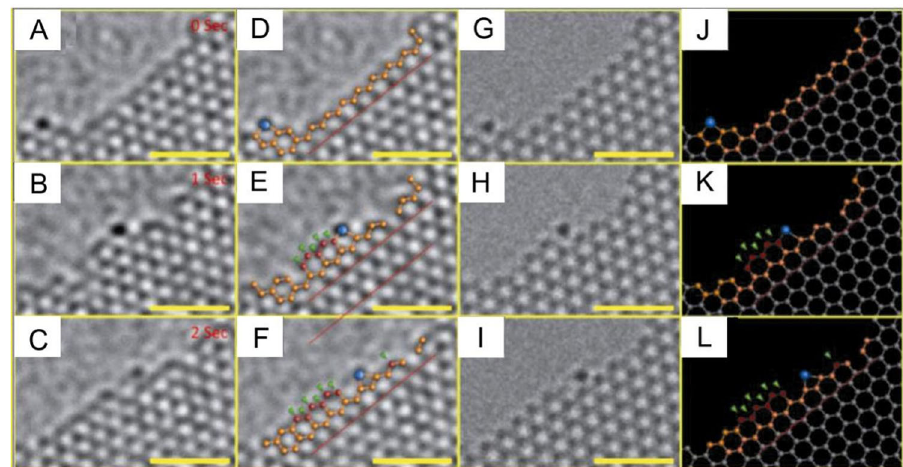
Fig. 5 Catalytic growth of graphene by a single Cr atom at the graphene edge under electron beam irradiation. A – C , with partial stick- and-ball models to aid viewing ( D ) – ( F ), image simulations of the growth process G – I , and complete stick-and-ball models J – L . The blue ball indicates Cr, whereas red balls and green arrows signify new C atoms. All scale bars are 1 nm. Reproduced with permission from Springer 20